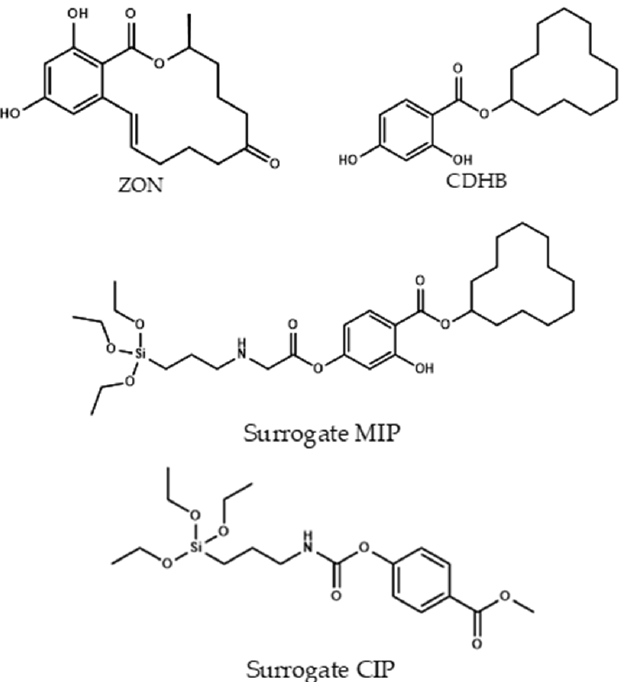
Figure 3. Chemical structures of zearalenone (ZON), CDHB, and surrogate ‐ MIP and surrogate ‐ CIP.